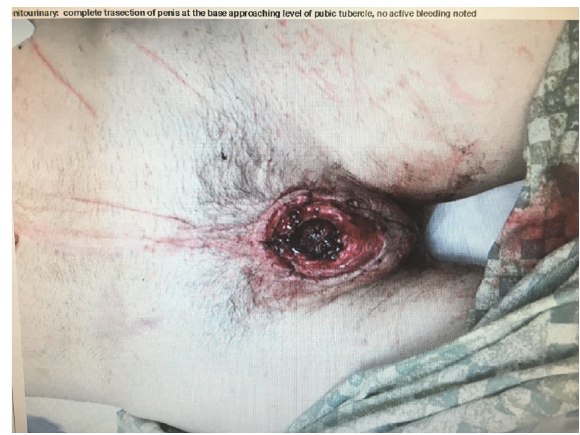
Figure 1: Amputated genitalia with cutting marks on abdomen and